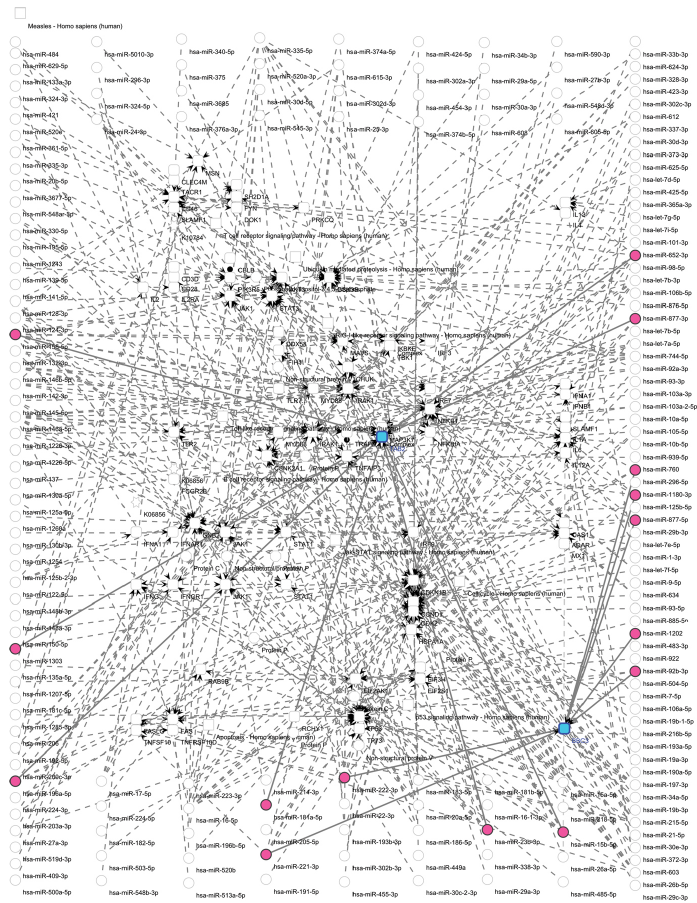
Figure 4: The miRNA-enriched human KEGG measles pathway. The blue squares represent TAB2 and BCC3 while miR- NAs targeting these two genes are marked pink. All miRNAs mapped to the pathway have been arranged along the sides not to disturb the view of the